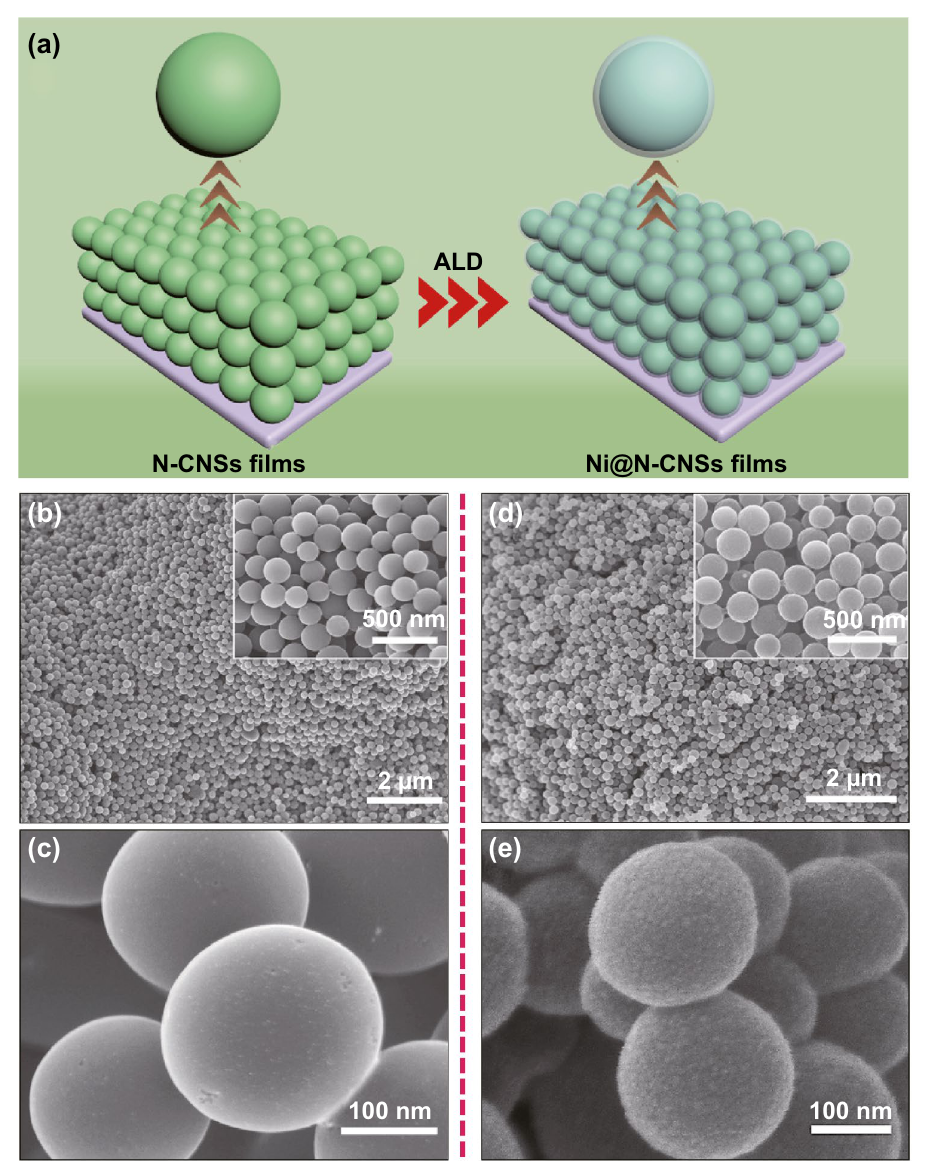
Fig. 1 a Schematic fabrication process of Ni@N-CNSs films. SEM images of b , c N-CNSs and d , e Ni@N-CNSs